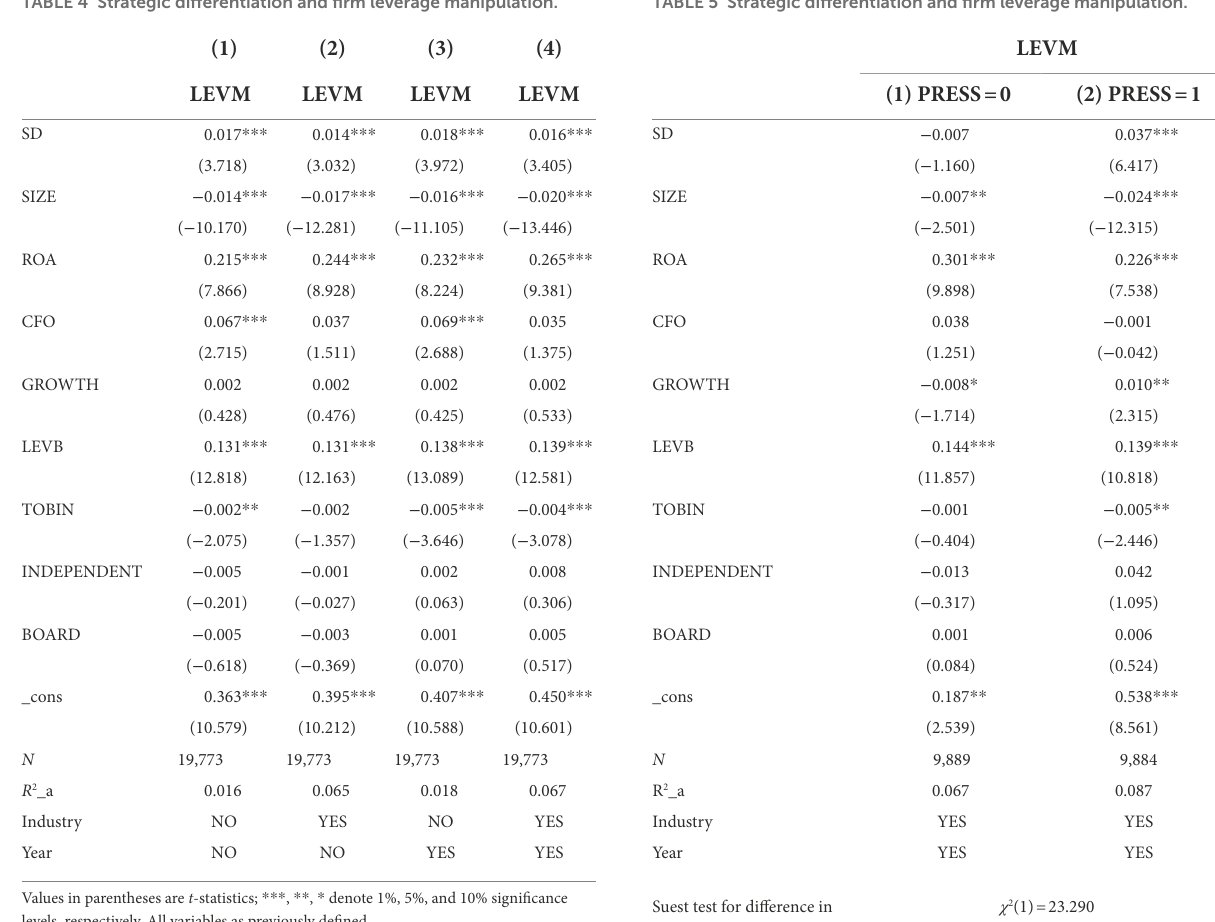
TABLE 4 Strategic differentiation and firm leverage manipulation. TABLE 5 Strategic differentiation and firm leverage